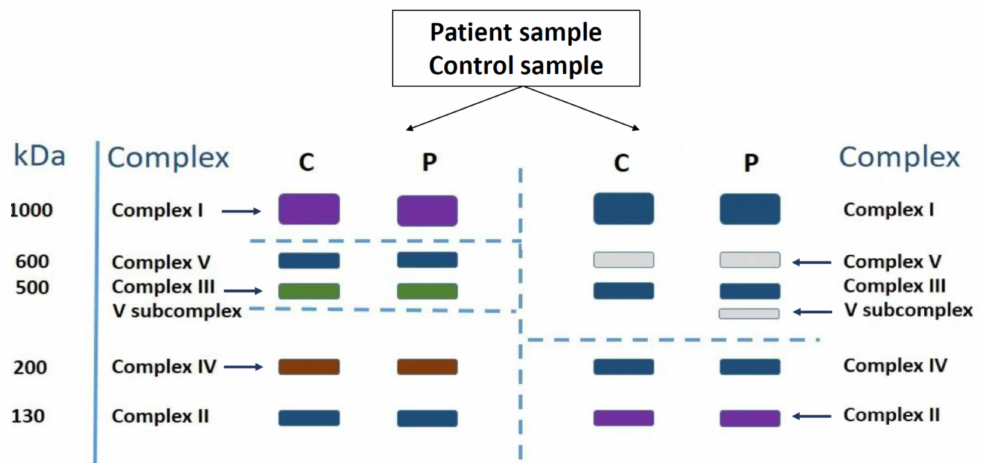
Figure 2. Schematic representation of BN-PAGE with in-gel activity staining. Dashed lines represent how the gel is cut into five fragments. The arrows indicate which OXPHOS complex activity is visualized in which gel fragment. P = patient sample, C = control